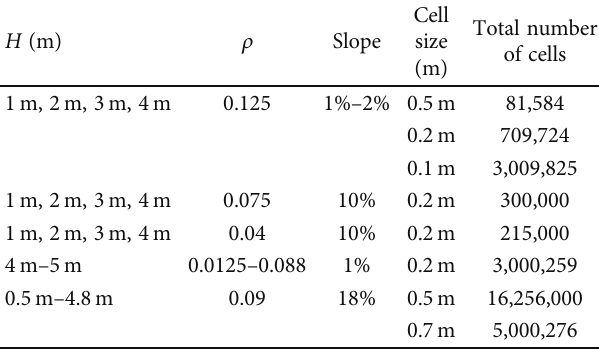
Table 2: Mesh convergence analysis.